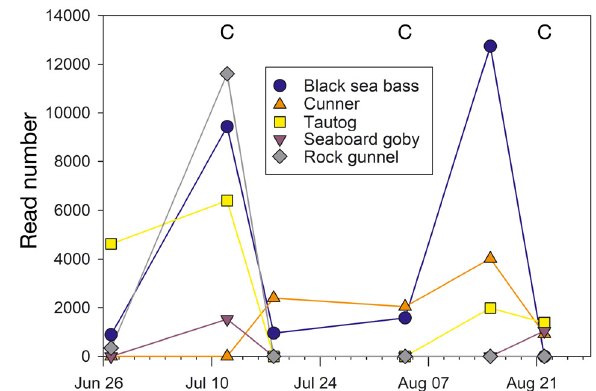
Fig. 6. eDNA read numbers for 5 structure-dependent spe- cies at the cage farm. The letter C indicates dates on which video recording also took